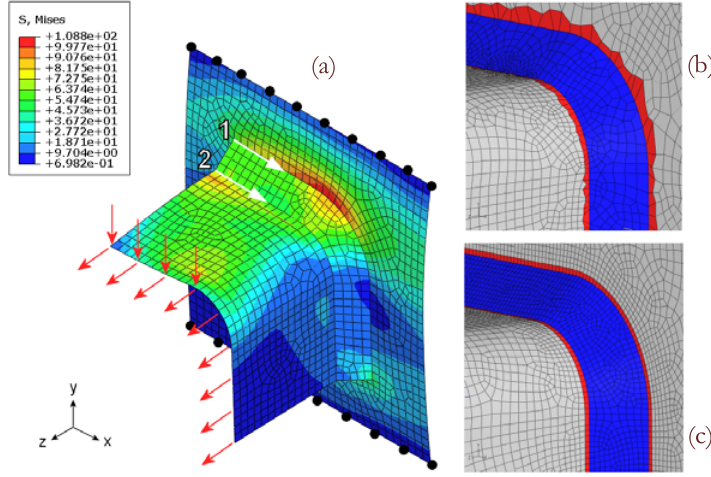
Figure 3: Curved profile welded to a flat plate: a) shell model using a coarse regular mesh at the toes; b)-c) close views of the fillet for the irregular mesh and the refined regular mesh.